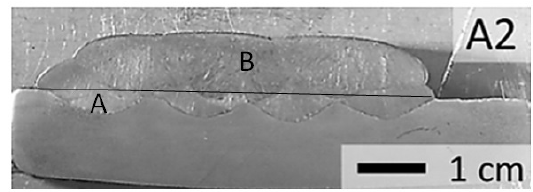
Figure 2. Macrograph of the welded test